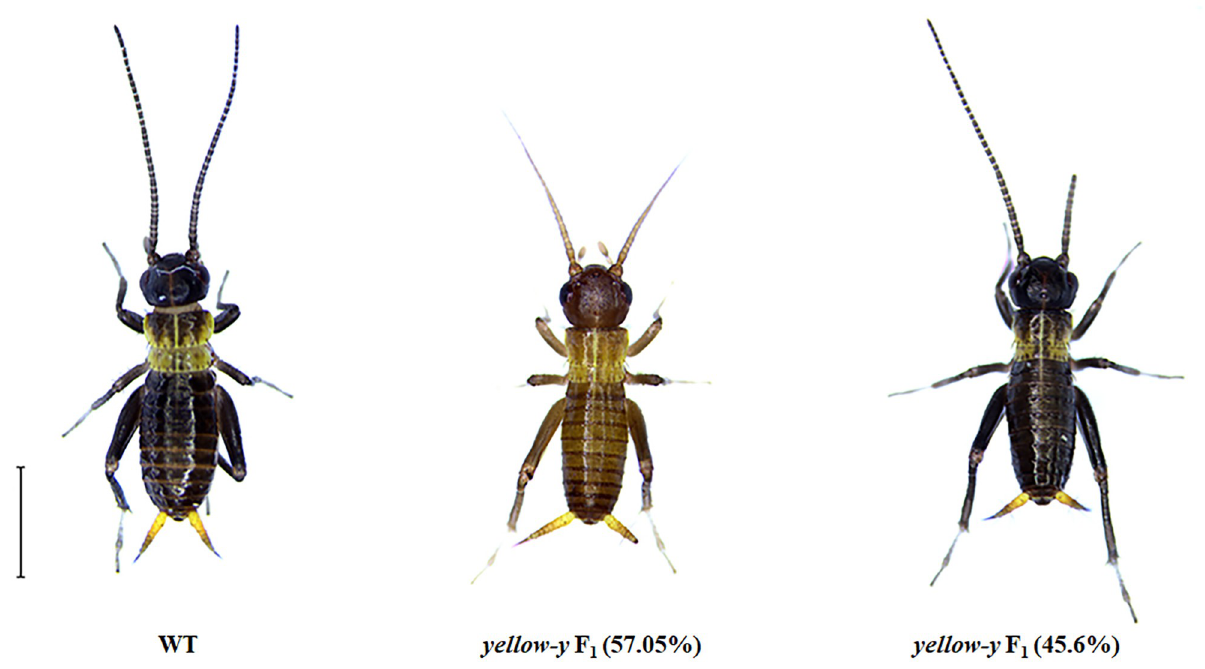
Fig 7. Phenotype analysis of the F 1 progeny of the yellow-y gene. Brown and black phenotypic differentiation appears in F 1 progeny. The F 1 progeny are viewed on the 8th-day of 1st larval instar. Bar = 3mm.